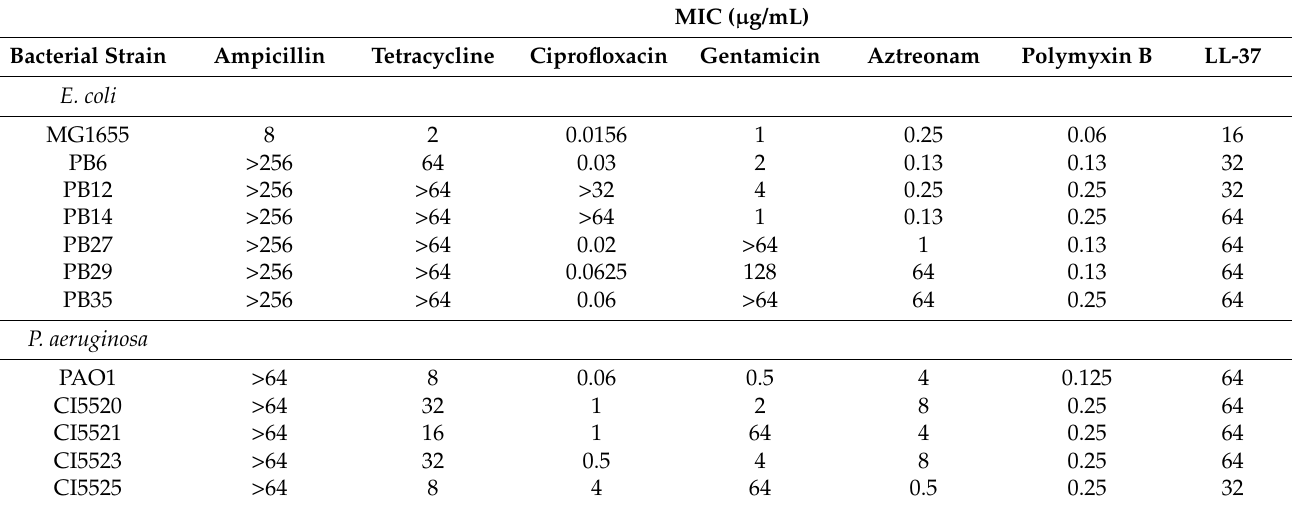
Table 1. Resistance profile of E. coli and P. aeruginosa strains used in this study. MIC ( µ g/mL)